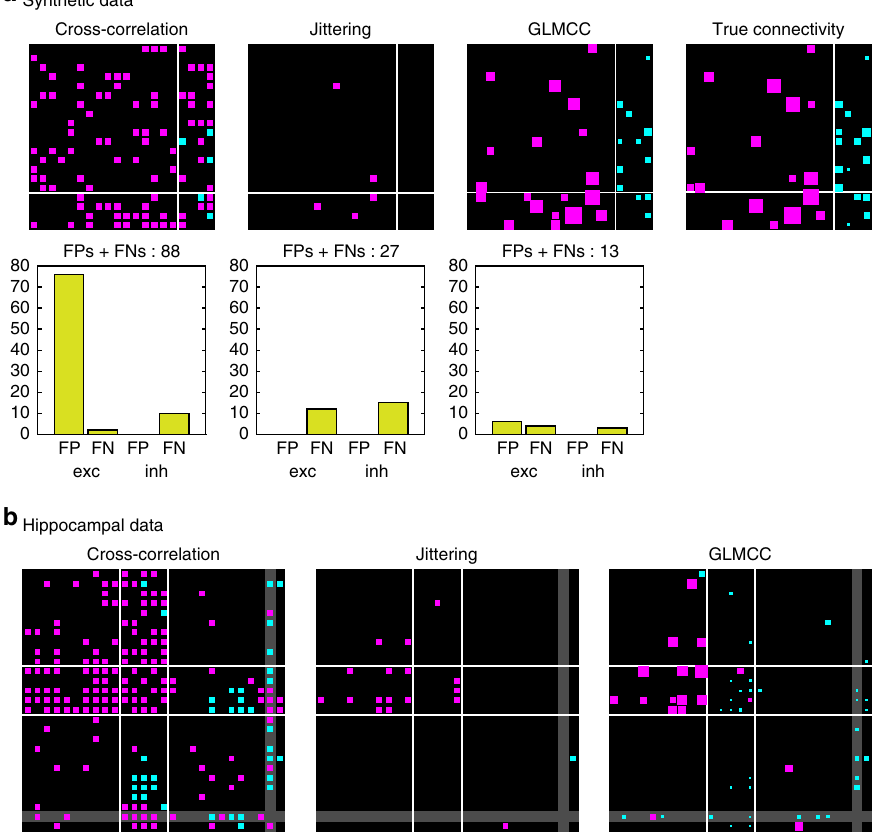
Fig. 6 Comparison of estimation methods. a Connections estimated using the conventional cross-correlation method, the jittering method, and our GLMCC method, in reference to the true connectivity of the synthetic data (used in Fig. 3). For the GLMCC and the true connectivity, the size of each square is proportional to the PSP amplitude, while for the fi rst two methods, the estimated connections are represented in equal size, because they do not estimate the PSP. b Neuronal connections estimated from spike trains recorded from the hippocampus of a rat (used in Fig. 5d). Source data are provided as a Source Data fi